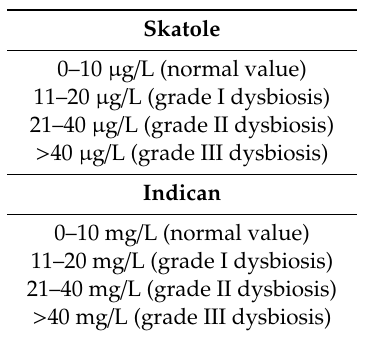
Table 1. Reference intervals for the dysbiosis